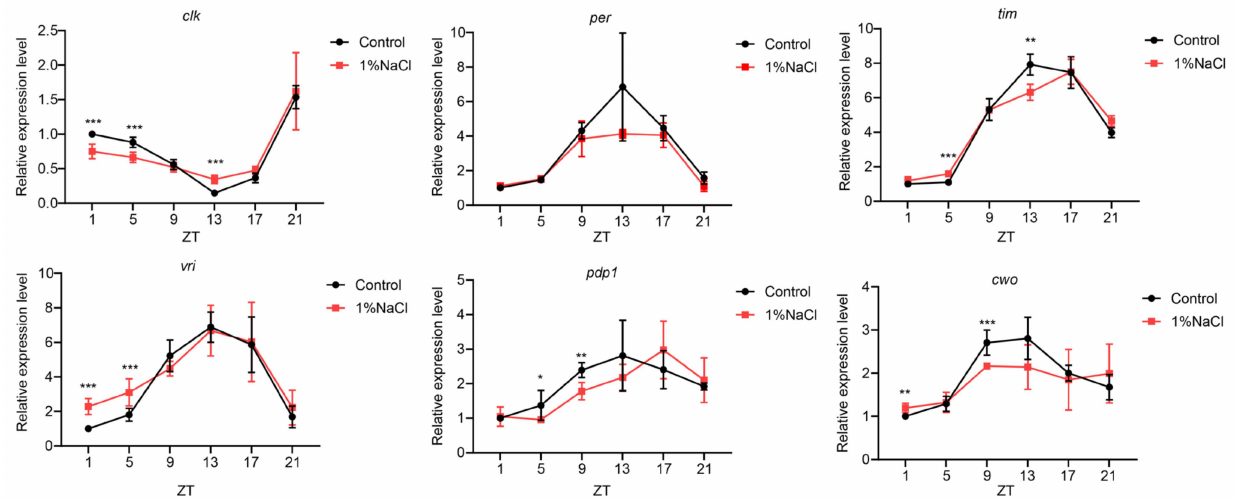
Figure 2. Oscillation of clock gene expression in head extracts of flies with or without HSD. An average of the normalized values was determined and plotted. RNA profiles were from 12L:12D cycles. The Mann-Whitney test was used to compare data at the same time point between control and flies fed 1% NaCl. * p < 0.05; ** p < 0.01; *** p <